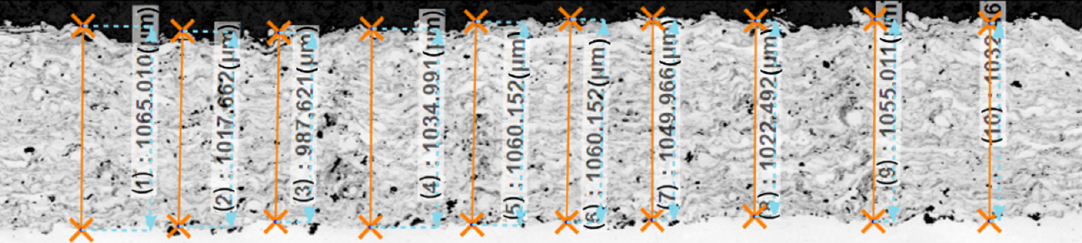
Figure 4. Validating coating thickness by microscopic measurements (mean value 1.038 mm).